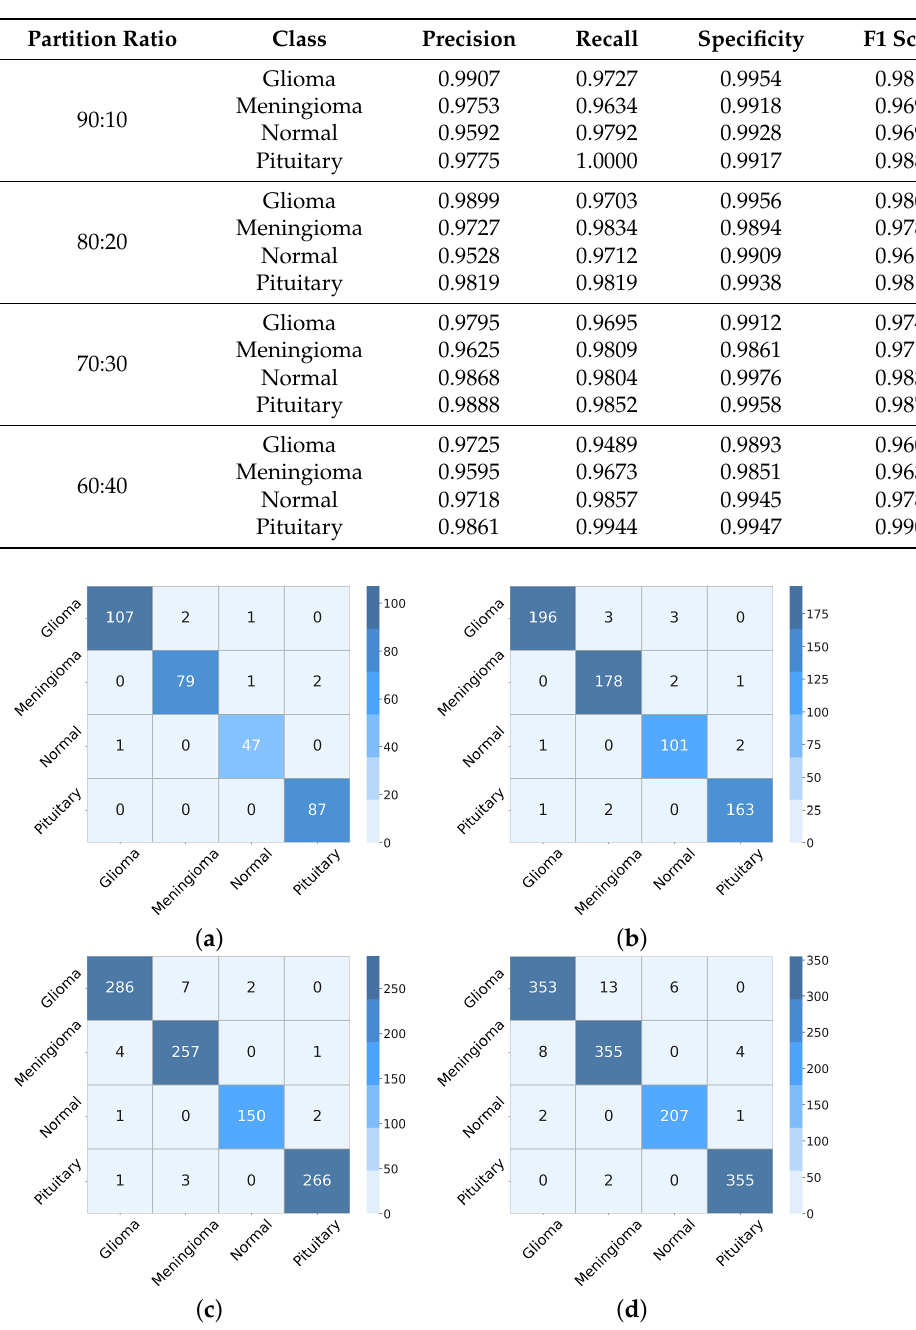
Table 6. Classification performance of the proposed method on dataset BT-4C.